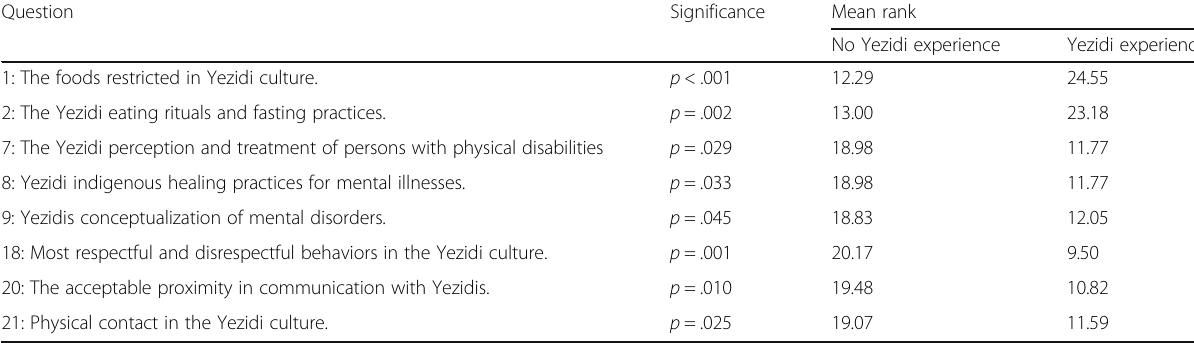
Table 1 Comparison on the knowledge of Yezidi culture among aid workers in Iraqi Kurdistan